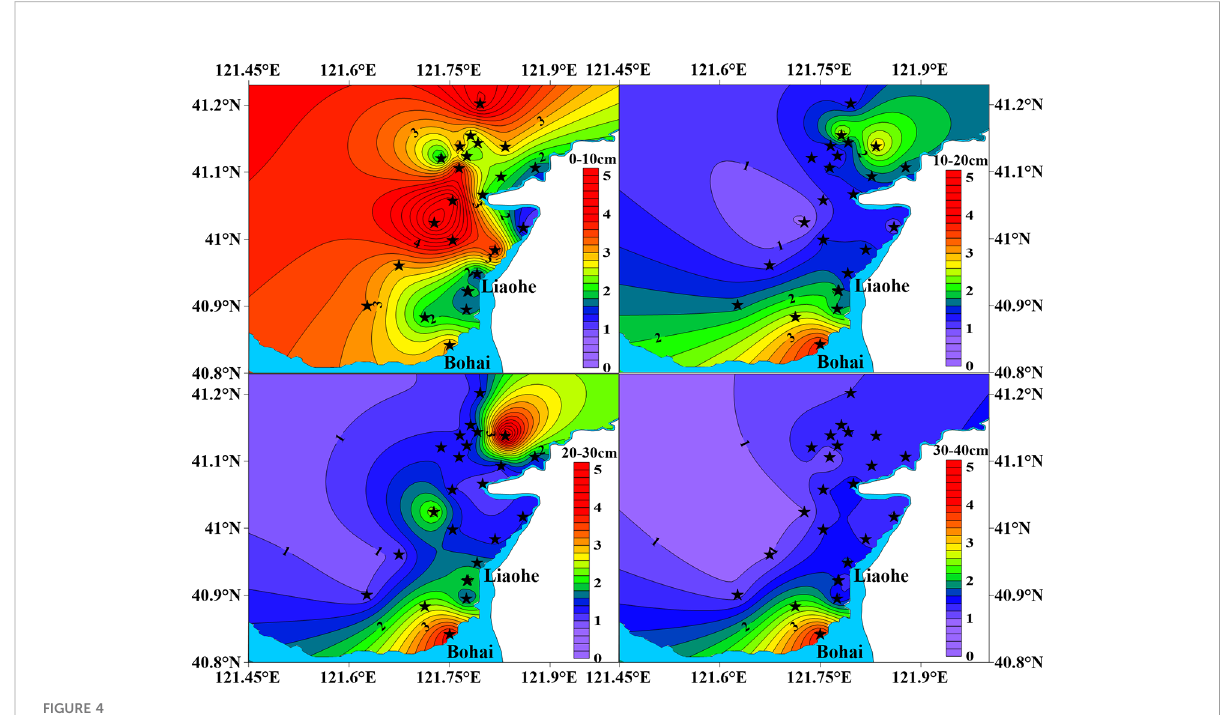
FIGURE 4 Nemerow pollution index for the Liaohe Delta under different